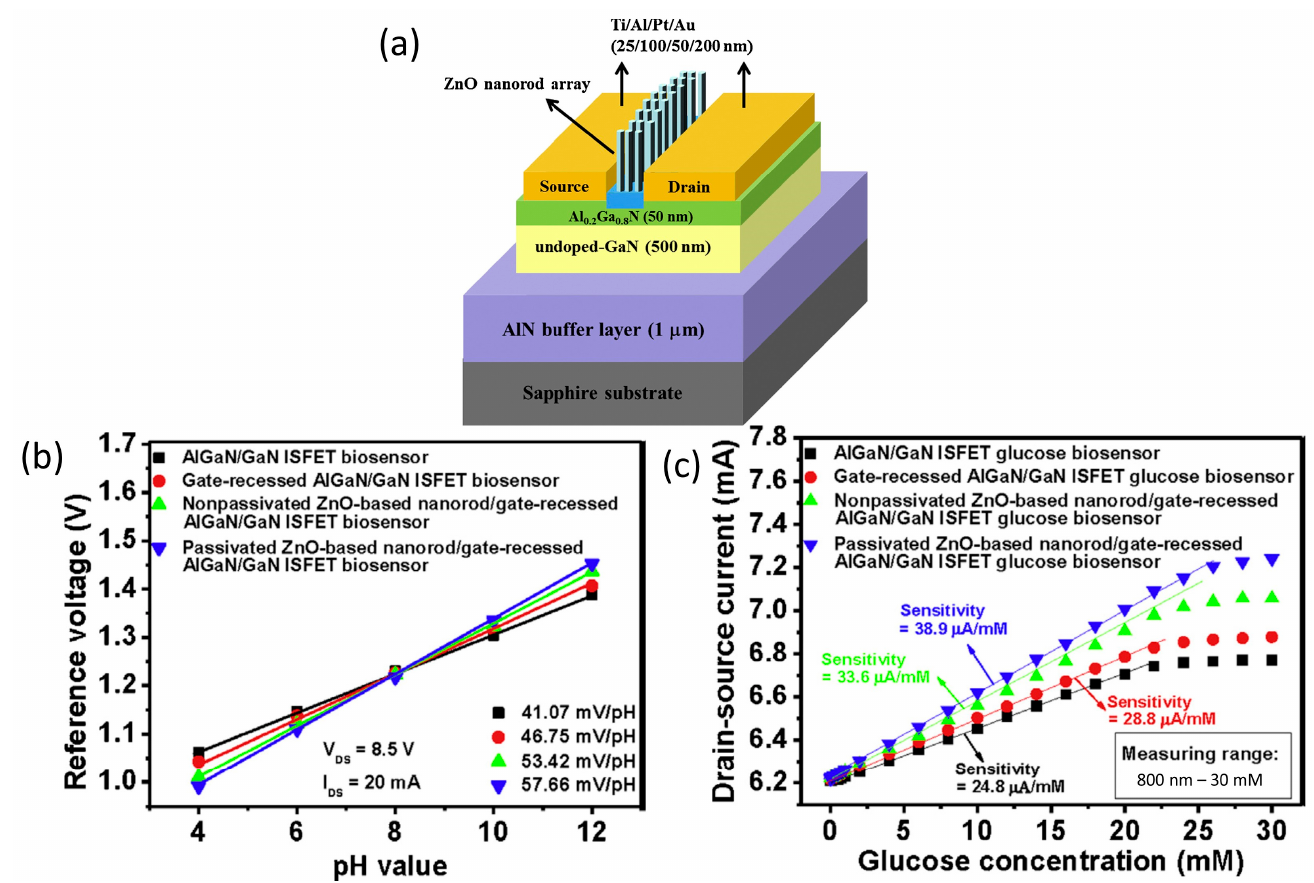
Figure 3. ( a ) Illustration of cross-sectional area of ZnO nanorod array-based HEMT sensor. ( b ) Ref- erence voltage as a function of pH values and ( c ) drain-source current as a function of glucose con- centration. Reprinted from reference [102]. Copyright 2015, with permission from Elsevier .